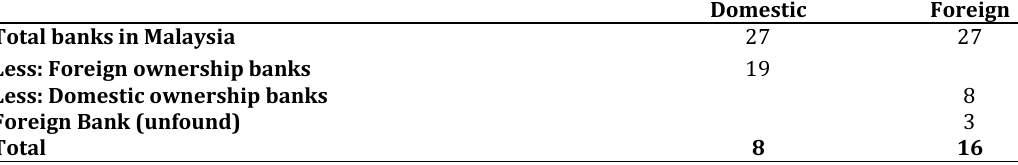
Table 3: Total sample size of domestic and foreign banks